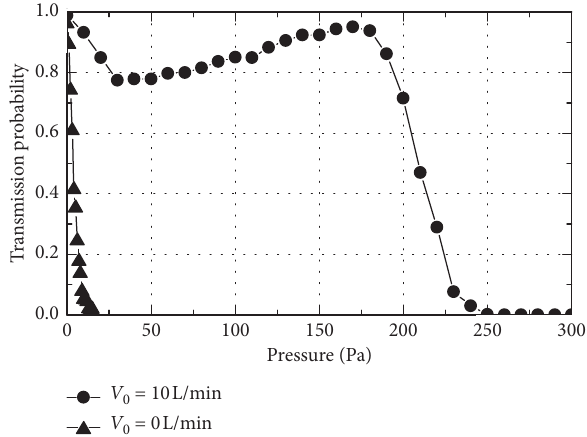
Figure 6: Comparison of the transmission probability when V 10L/min and